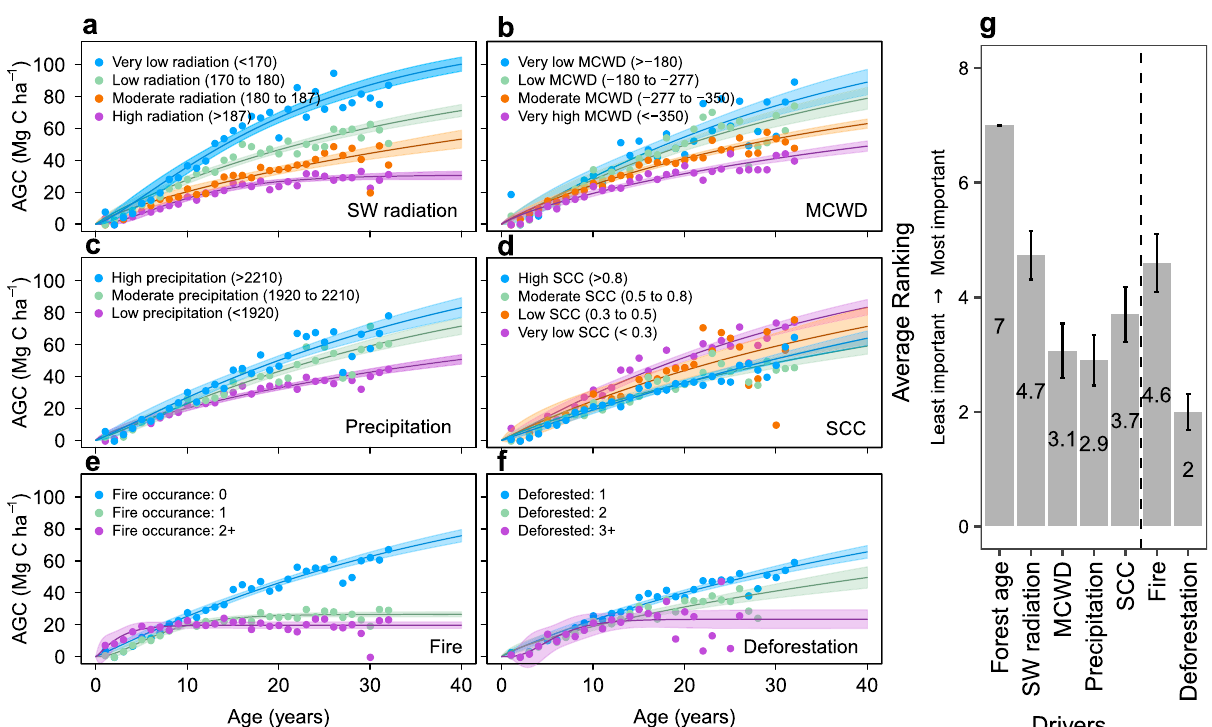
Fig. 1 Secondary forest carbon accumulation with increasing age under different driving conditions. Drivers are a Annual mean downward shortwave (SW) radiation (Wm − 2 ), b Maximum Cumulative Water De fi cit (MCWD; mm yr − 1 ), c Annual mean precipitation (mm yr − 1 ), d Soil Cation Concentration (SCC; cmol( + ) kg − 1 ), e Fire occurrences between 2001 and 2017, and f Number of deforestations prior to regrowth between 1985 and 2017, where 1 refers to areas that have only experienced the original conversion from old-growth forest to secondary forests during the period 1985 – 2017 with no subsequent deforestation events. The bar graph g shows the average importance ranking of the drivers ( a – f ), as well as Forest age, in in fl uencing Aboveground Carbon (AGC) accumulation. The average ranking was calculated following 30 iterations of a conditional random-forest model. The importance has been ranked from least important (1) to most important (7) and the vertical dotted line separates environmental drivers (left) from anthropogenic disturbance drivers (right). Shading in a – f denotes the 95% con fi dence interval of the models, based on the median value of the initial data for each age — dots in fi gures. The error bars in g denote the 95% con fi dence